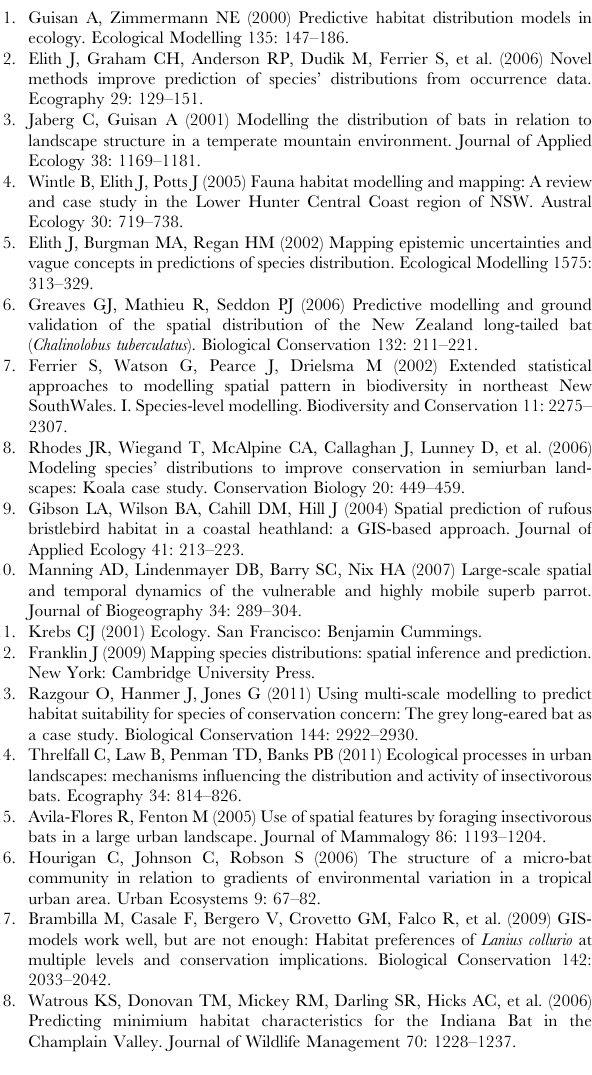
Table S1 Description of candidate variables used in the analyses. Values are mean 6 se (range) or frequency of ordinal values. A patch was defined as . 10 trees occurring together and patch sizes . 500 m 2 were